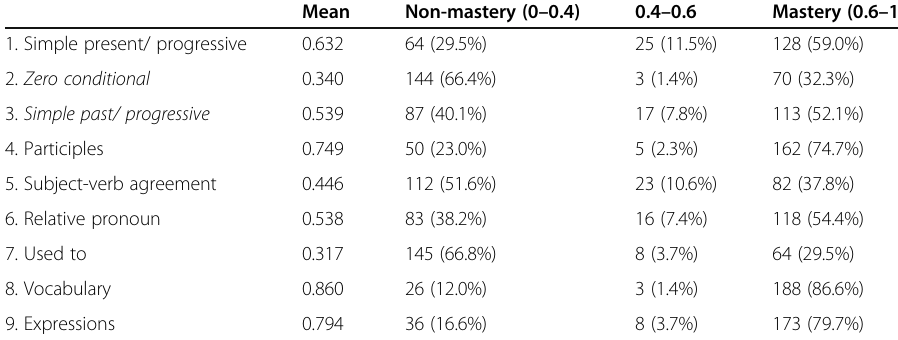
Table 7 Mean mastery probabilities and 217 examinee percentages on the first